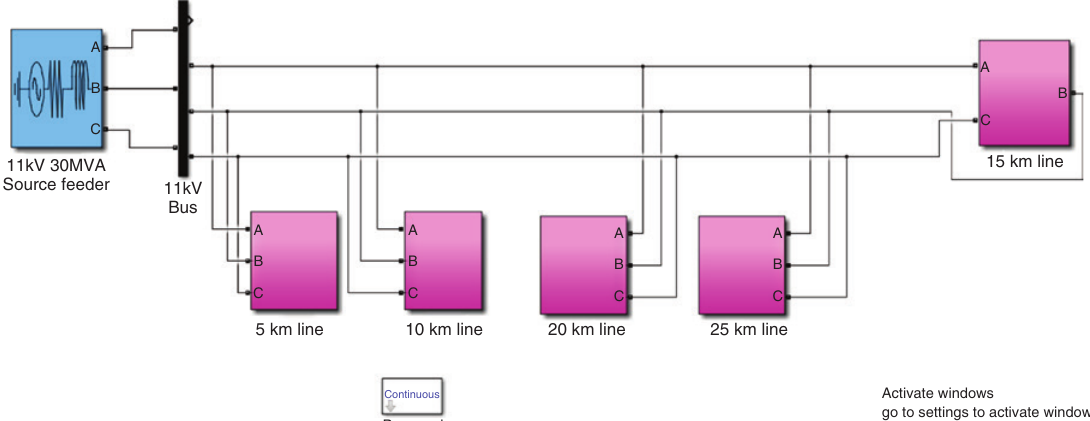
Figure 6: Simulink Model of a Power Distribution System with Loading at Five Different